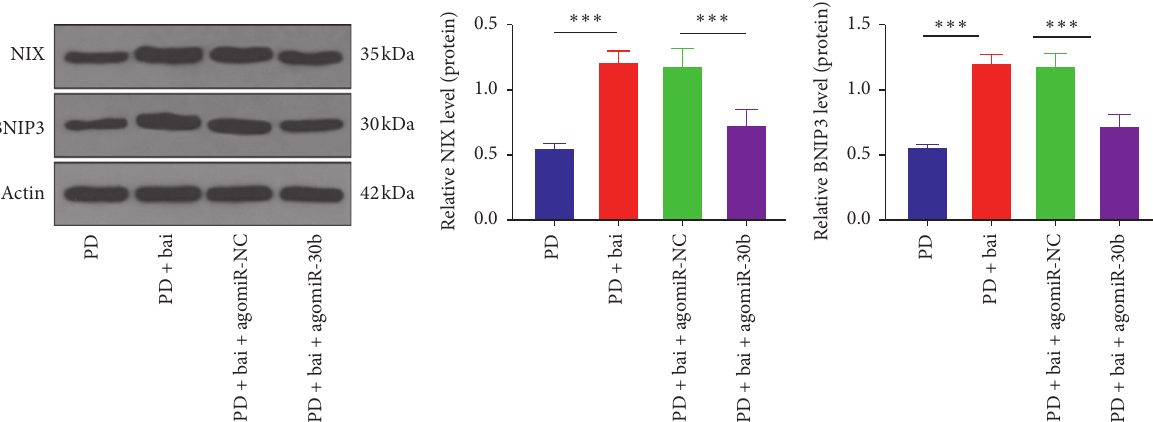
Figure 6: Baicalein mediated mitochondrial autophagy via miR-30b and the NIX/BNIP3 signaling pathway. The effect of miR-30b on the NIX/BNIP3 signaling pathway was observed by transfecting agomir-30b in PD rats. (a) The expressions of NIX and BNIP3 were detected by WB. N � 6. The data in the figure are all measurement data and the data are expressed as mean ± standard deviation; one-way ANOVA was used for variance analysis; Tukey’s multiple comparisons test was used for post hoc test. ∗∗∗ P < 0 .